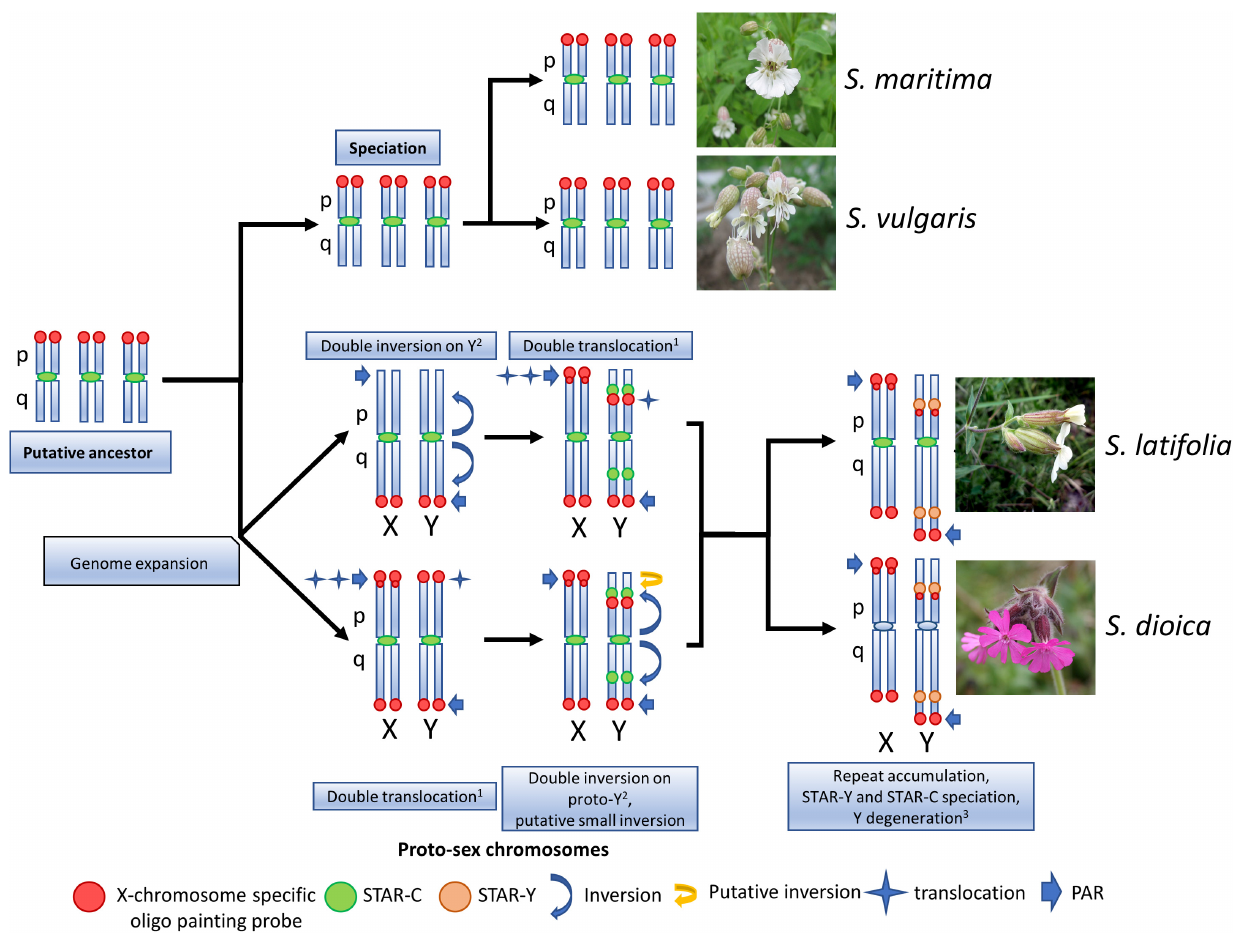
FIGURE 3 | Schematic view of the sex chromosomes evolution in S. latifolia and S. dioica . The sex chromosomes in S. latifolia and S. dioica underwent at least one double translocation 1 (Bergero et al., 2013; Campos et al., 2017) and double inversion 2 events (Hobza et al., 2007; Zluvova et al., 2007; Bergero et al., 2008a; Kazama et al., 2016). Compared to gynodioecious species ( S. vulgaris and S. maritima ), S. latifolia and S. dioica possess two sex chromosomes having signal from hybridized oligo painting probe. Based on the oligo painting probe signal in this study, two scenarios (supported by the literature) could led to the formation of sex chromosomes in S. latifolia and S. dioica. If the double translocation moving the segments of STAR-C satellite occurred first, then the autosomal parts have been translocated to proto-sex chromosome X PAR and interstitial Y p-arm region (upper scenario). In the second scenario, the autosomal parts were translocated to the sex chromosomes first, followed by double translocation and at least one putative translocation on the Y p-arm. Flower pictures downloaded on: